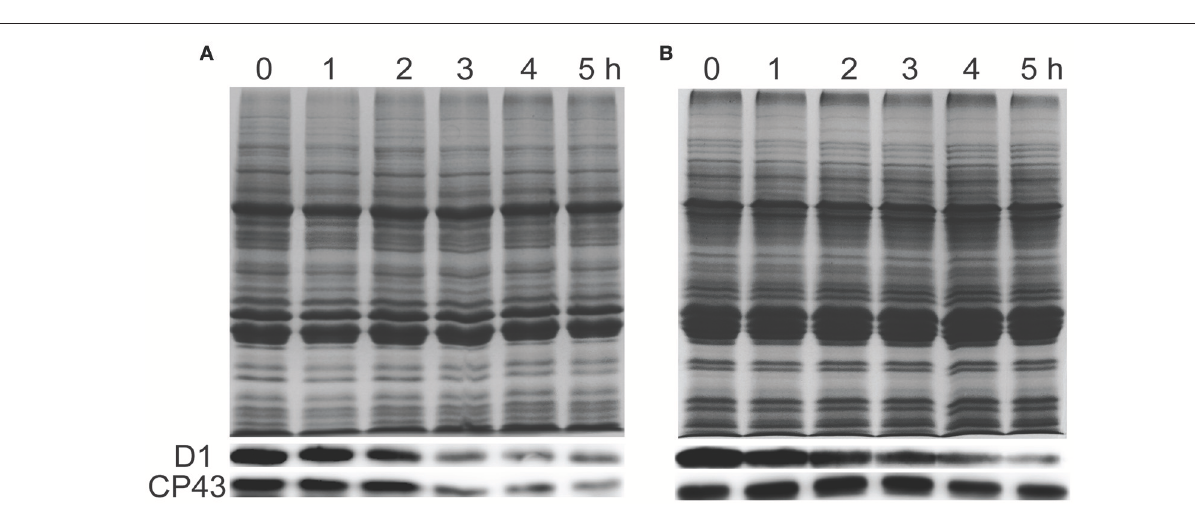
does acidify the medium, and 4 does alkalinize it. However, OH 3